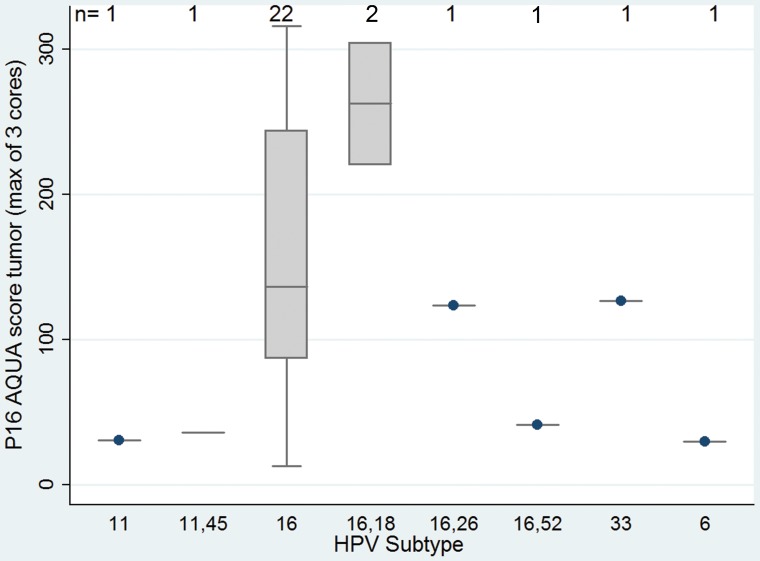
P16 expression by AQUA according to HPV subtype.